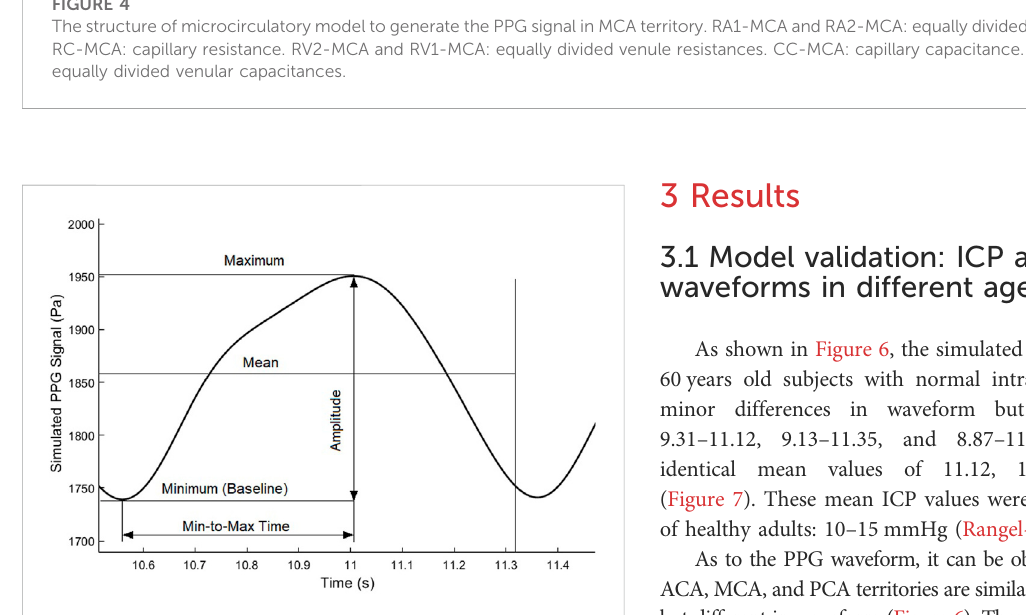
FIGURE 5 Basic waveform features of a simulated PPG signal in a cardiac